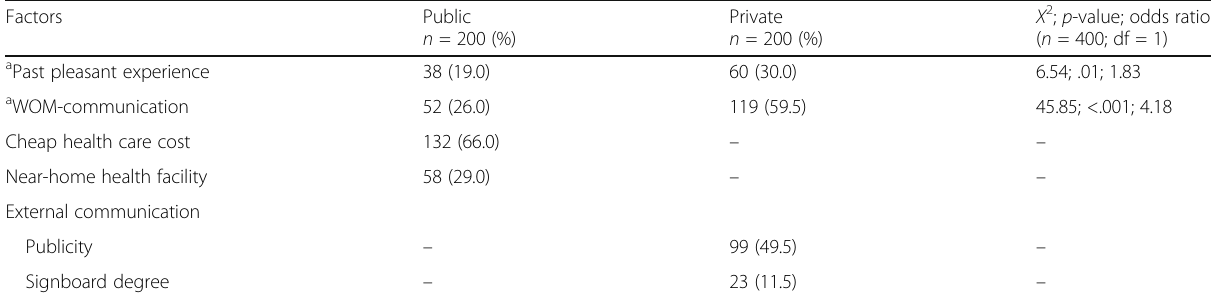
Table 3 Frequencies of the factors influence public and private clients ’ expectation and utilization of health facilities with